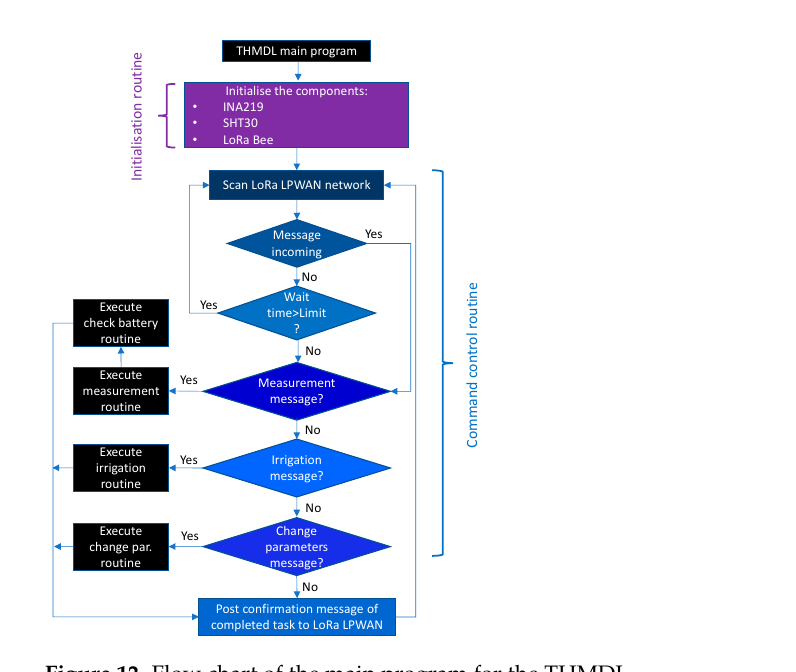
Figure 12. Flow chart of the main program for the THMDL.